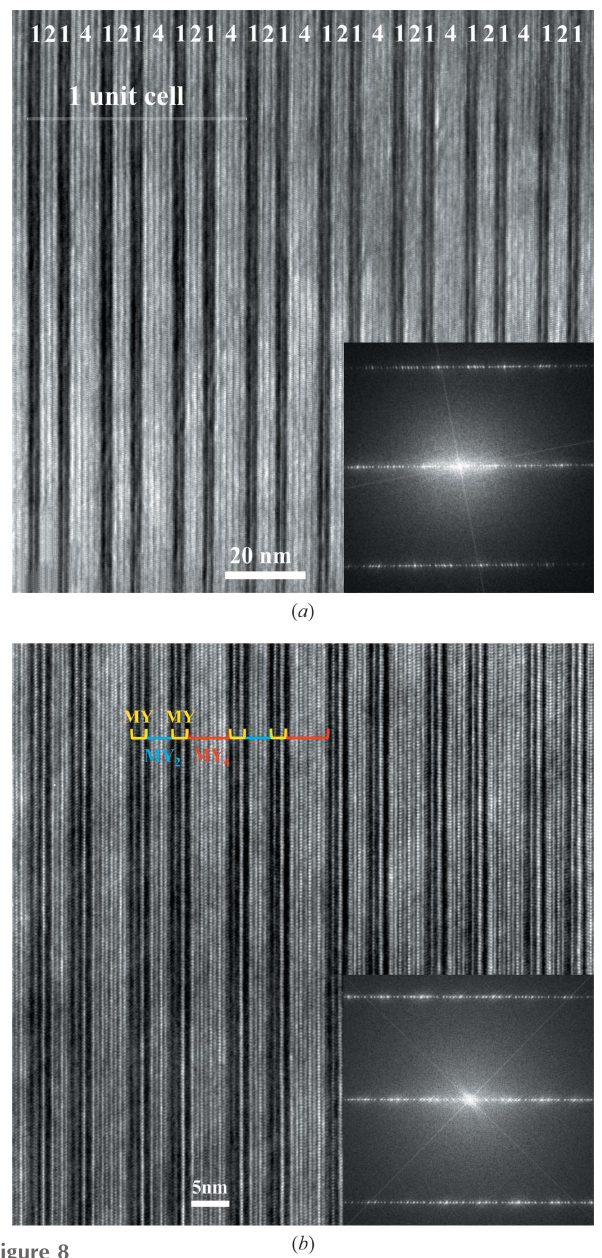
Figure 8 Experimental [100] HREM images collected on an FIB preparation of the (68) 3 hexaferrite single crystal and its corresponding FFT. These two images highlight the (MYMY 2 MYMY 4 ) 3 stacking sequence. The darker stripes are 25.9 A ˚ long and correspond to ‘MY’ sections. The brighter stripes are related to ‘MY 2 ’ and ‘MY 4 ’ sections and are 40.9 and 69.9 A ˚ long, respectively. The (MYMY 2 MYMY 4 ) 3 sequence is indicated through the photograph as ‘1214’ which refers to number succession of Y blocks only. The white rectangle in ( a ) represents one unit cell, containing a threefold repeat of the (MYMY 2 MYMY 4 ) 3 stacking sequence, shown on a shorter length scale in ( b ). The observed periodicity in the FFT is consistent with the primitive repeat of 162 A˚